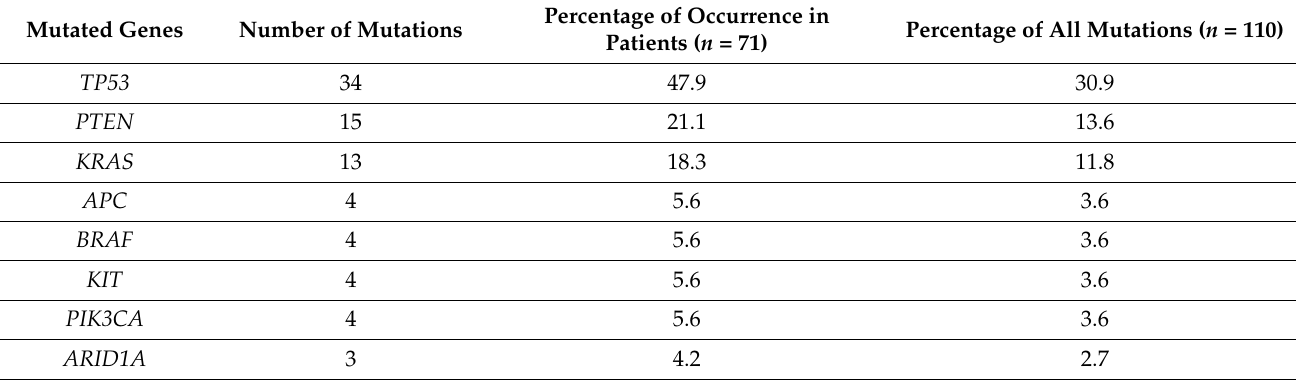
Table 2. Genomic profile of the therapy-refractory solid tumors ( n =